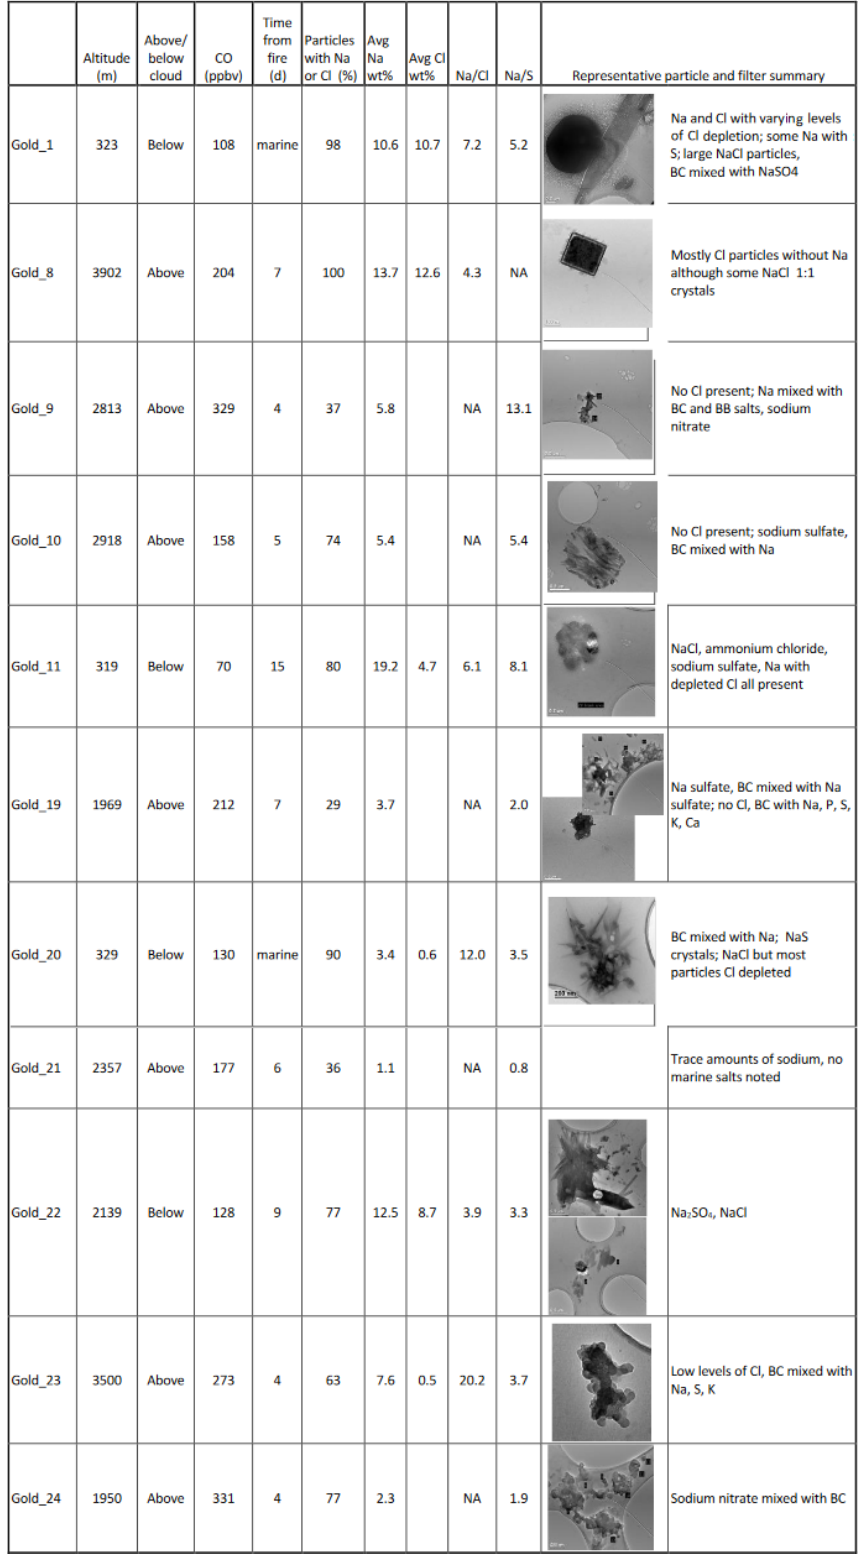
Table 3. Na-dominant aerosols on CLARIFY filters with sampling location, CO levels, time from source and percentage of particles on the filter with either Na or Cl. The ratios represent the weight percent ratio per particle, averaged across all particles with the elements of interest on each